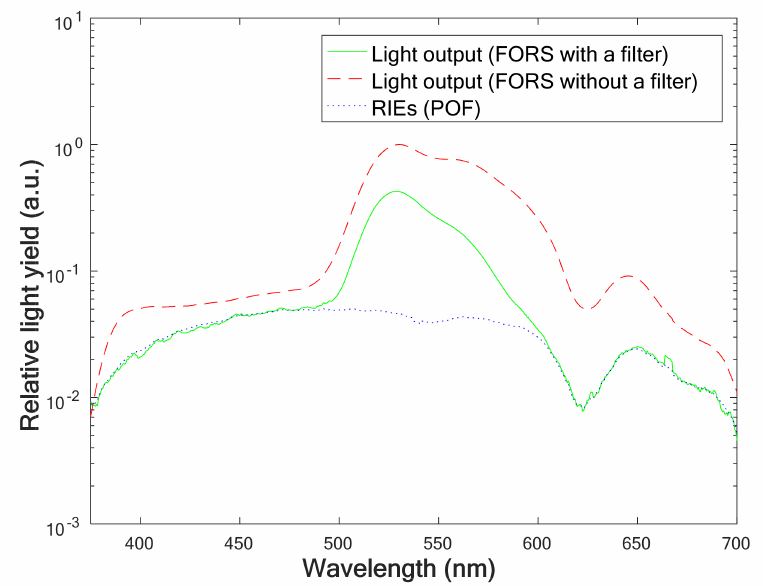
Figure 4. Measured spectra of light outputs of FORSs and the